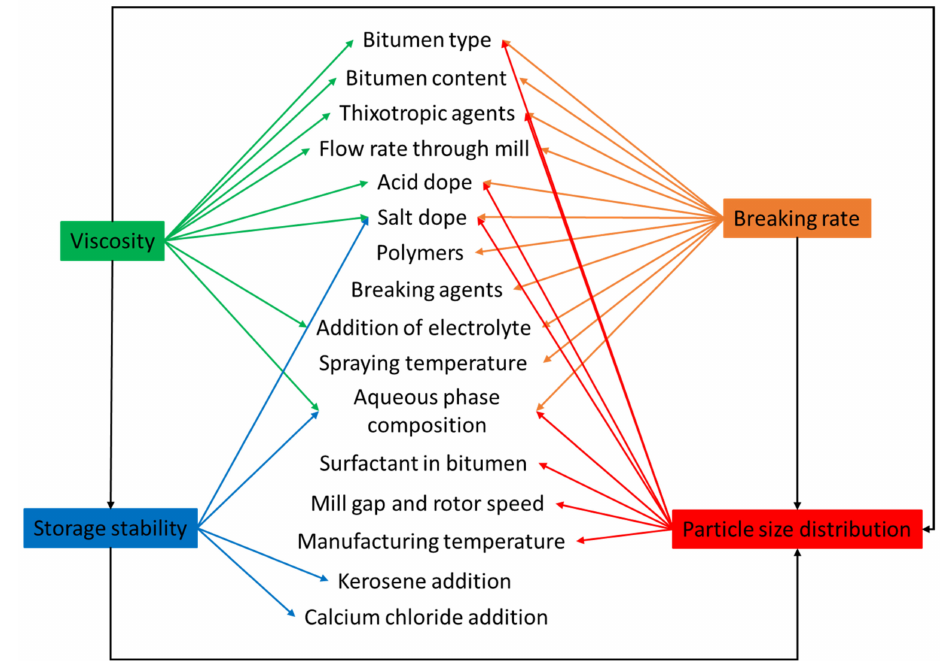
Figure 7. The interrelationship between manufacturing variables and properties for bitumen emulsion adapted from